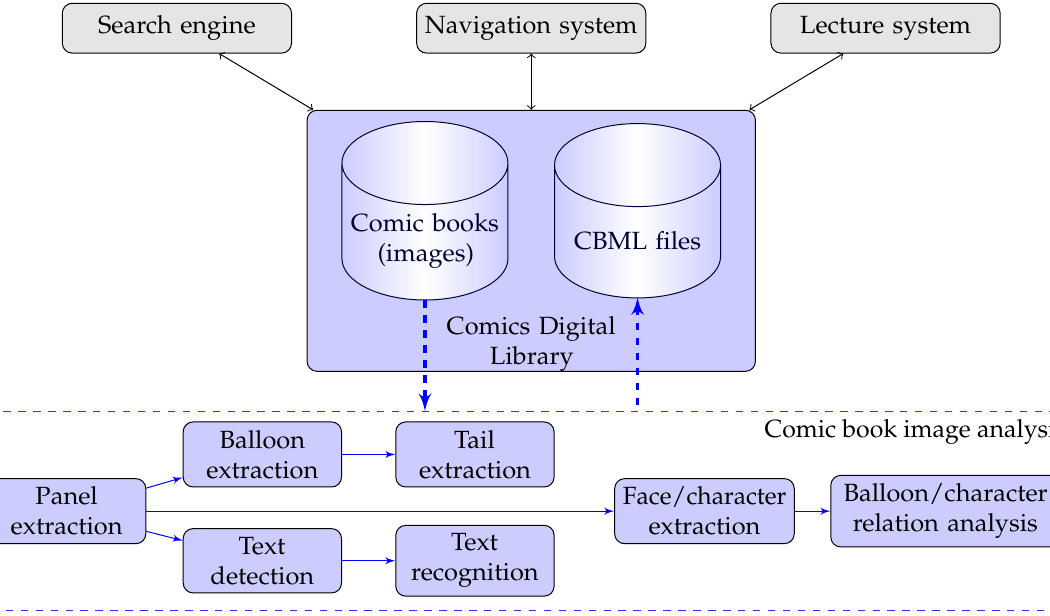
Figure 2. Illustration of the proposed architecture. Offline and online procedures are represented as blue and grey blocks,